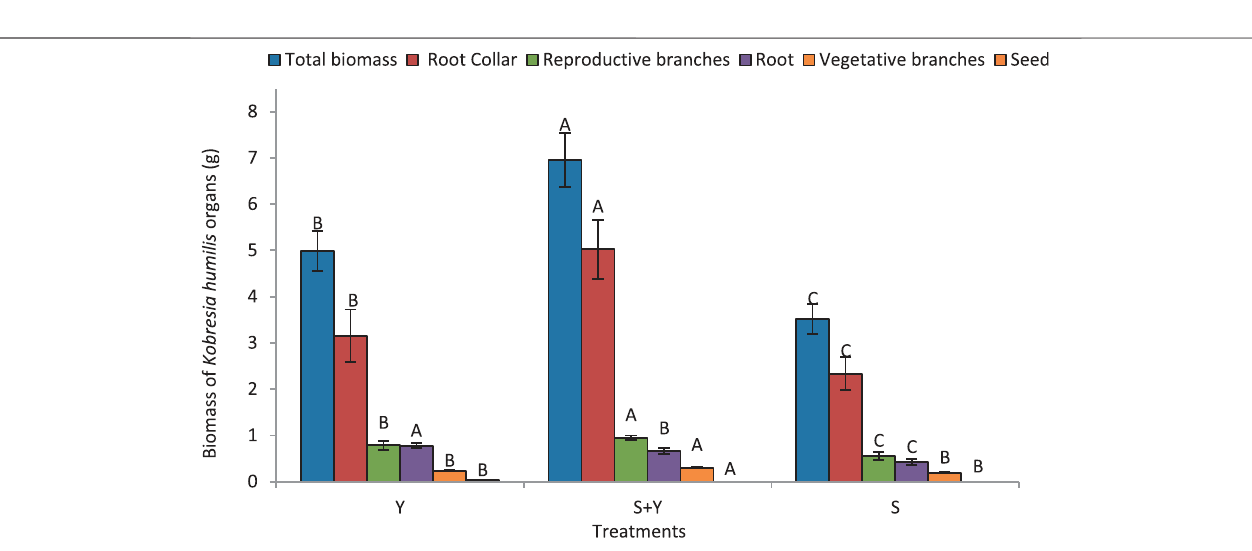
Frontiers in Environmental Science |